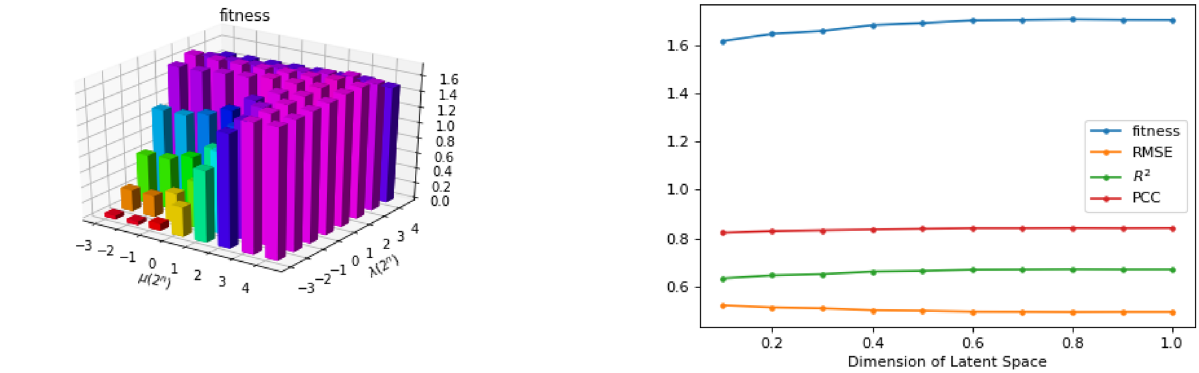
Figure 1. The effect of choosing different values of hyper-parameters on ADRML performance.